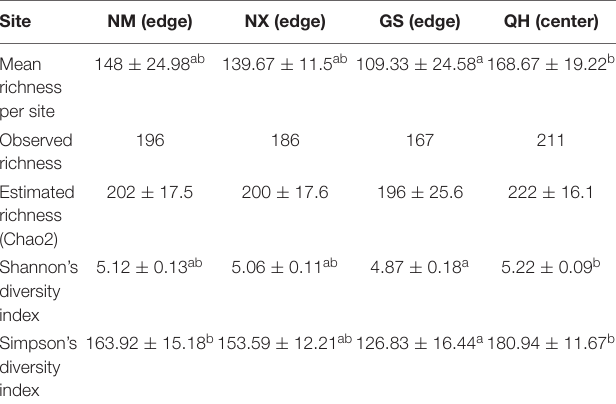
TABLE 2 | Summary of ectomycorrhizal fungal diversity associated with P. crassifolia.